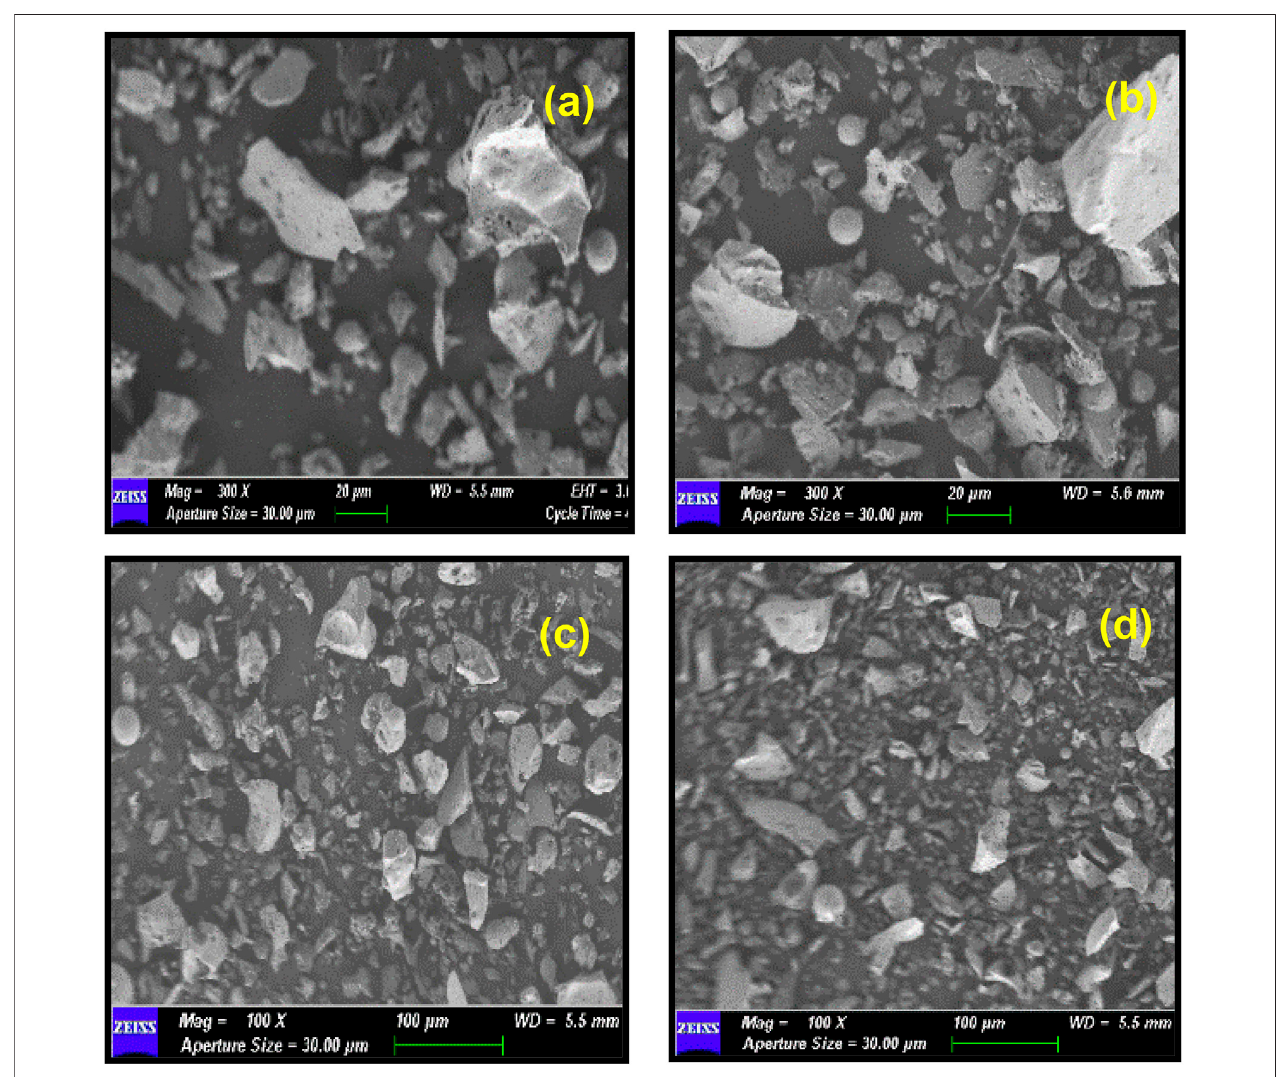
FIGURE 3 | SEM images for 45 and 75 µm of CBA under ×300 (A,B) and ×100 (C,D) magni fi cations.